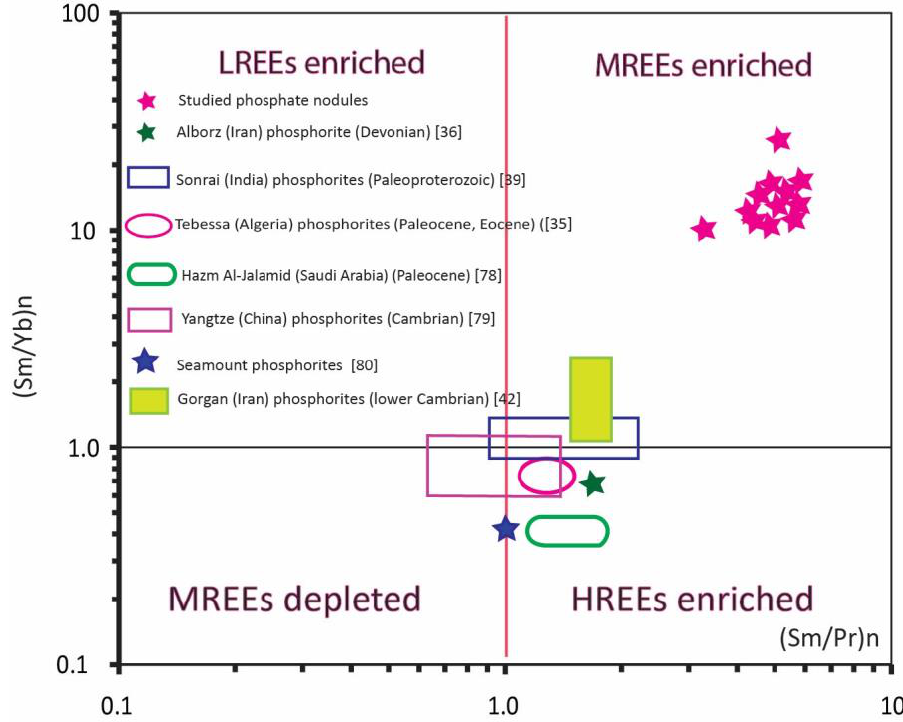
Figure 8. (Sm/Pr) n and (Sm/Yb) n relationships in the phosphate nodules (taken from [36,78 – 80]).